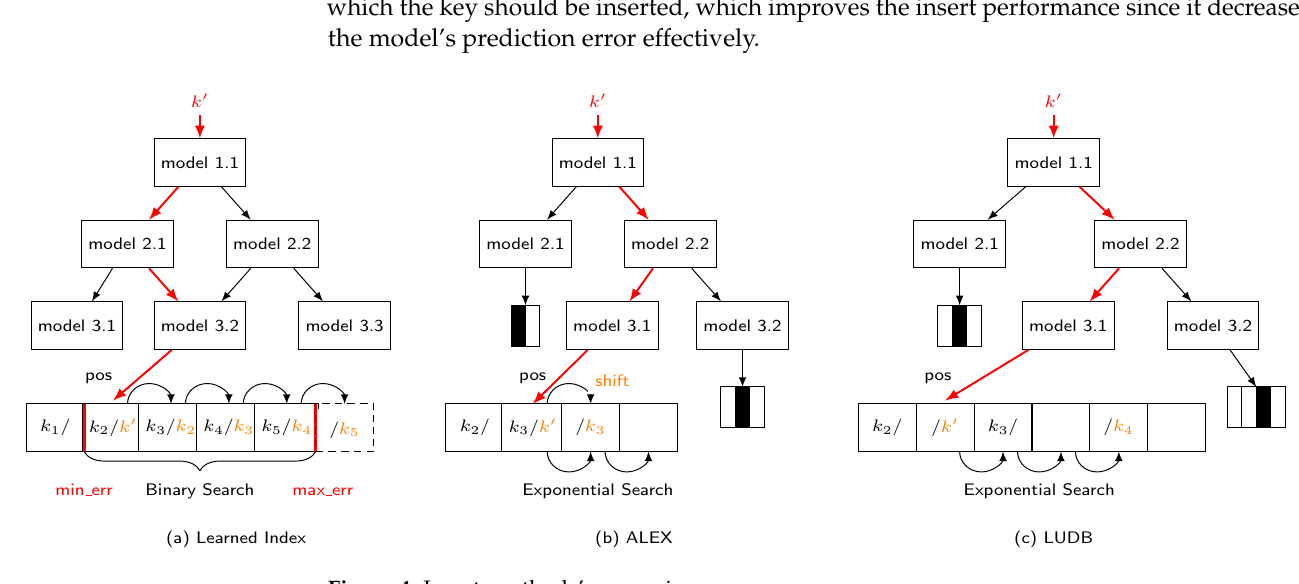
Figure 4. Insert methods’